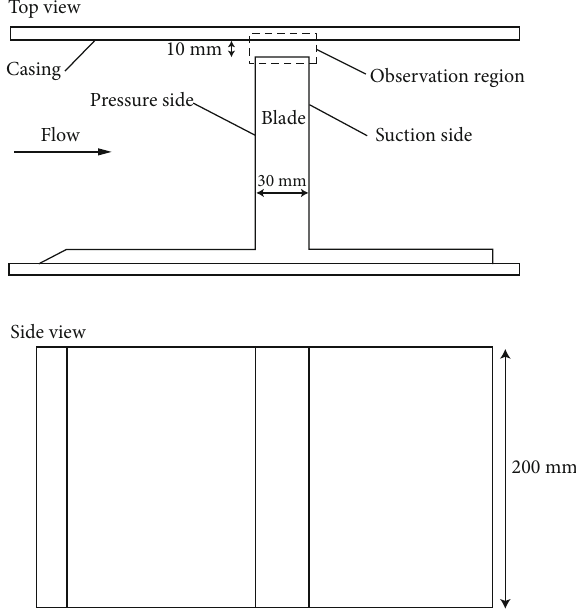
Figure 2: Schematic of the experimental Q-3-D gap